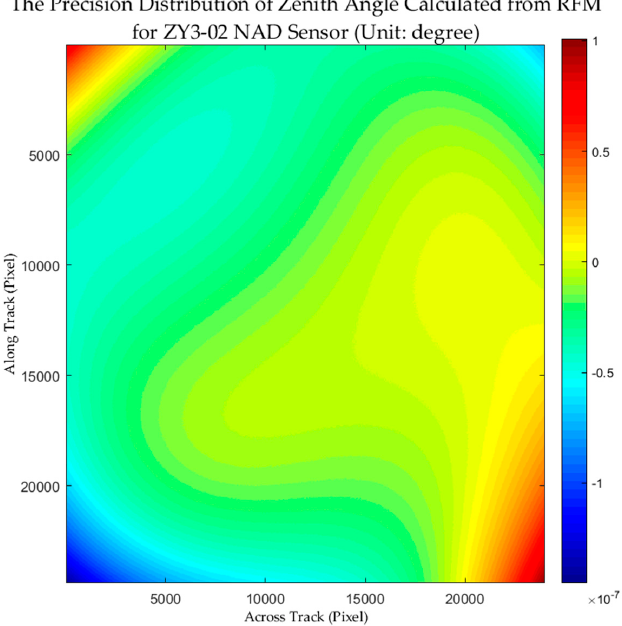
Figure 8. Precision distribution for the zenith angle calculated from the Rational Function Model (RFM) for ZY3-02 panchromatic nadir (NAD) sensor (unit: degrees).